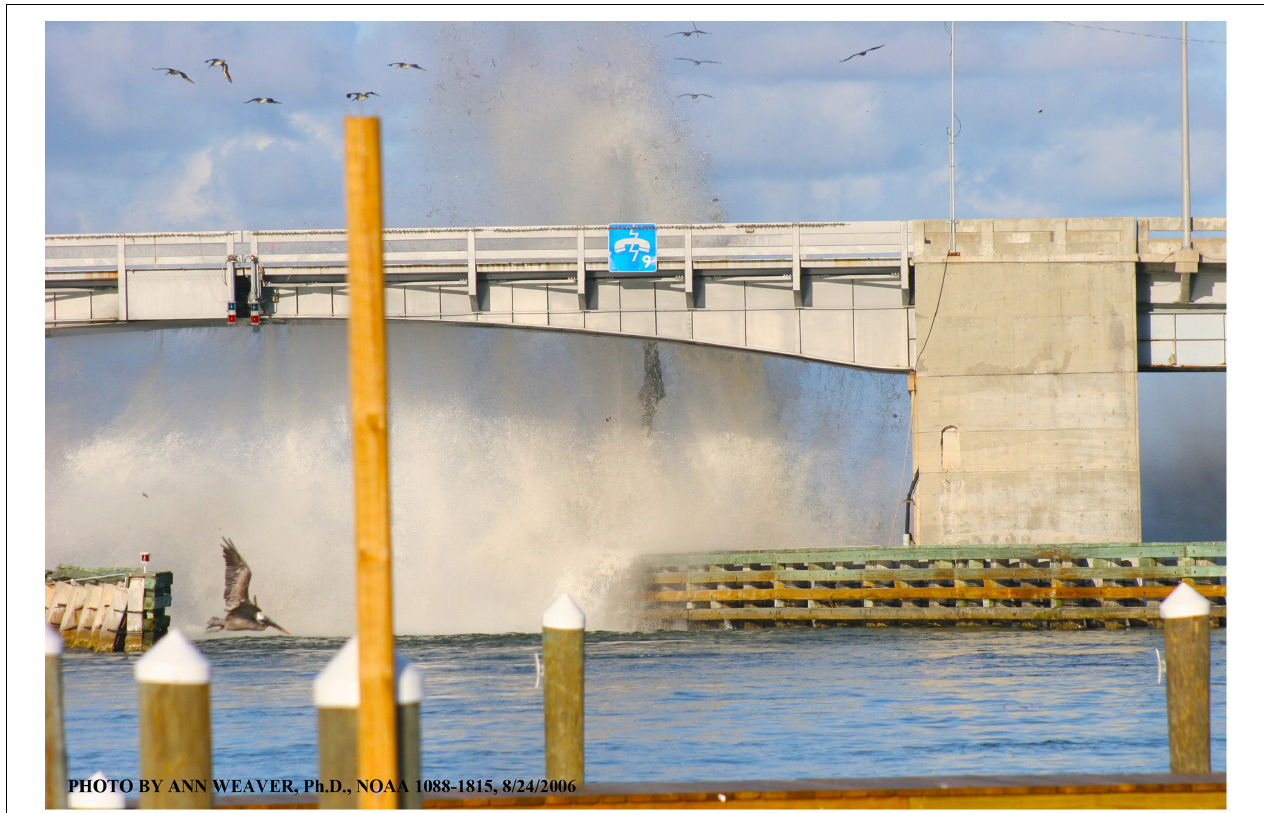
FIGURE 4 | Bridge replacement included four separate explosions (dynamite) to remove below-water cement structures, with commensurate habitat destruction and personal observations of extensive fish kills. This image shows demolition of the submerged portions of the lift tower on the NW portion of the W